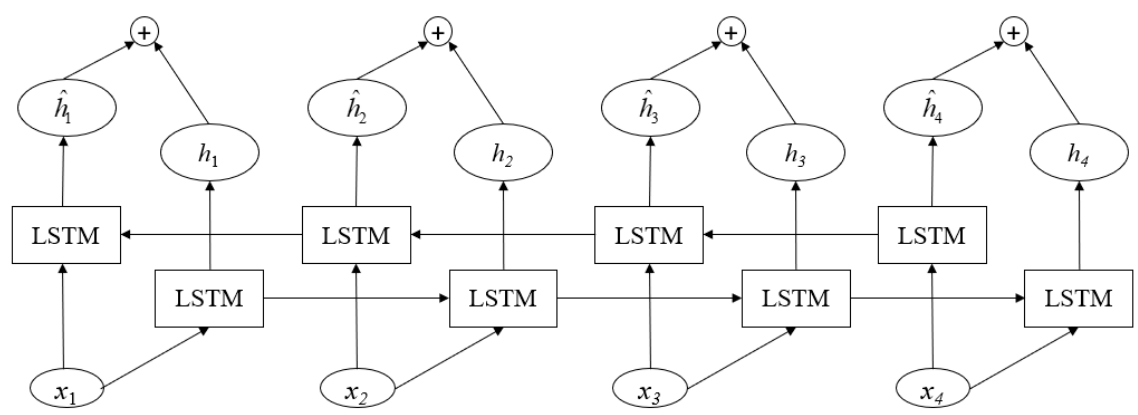
Figure 4. Structure of Bi-LSTM.